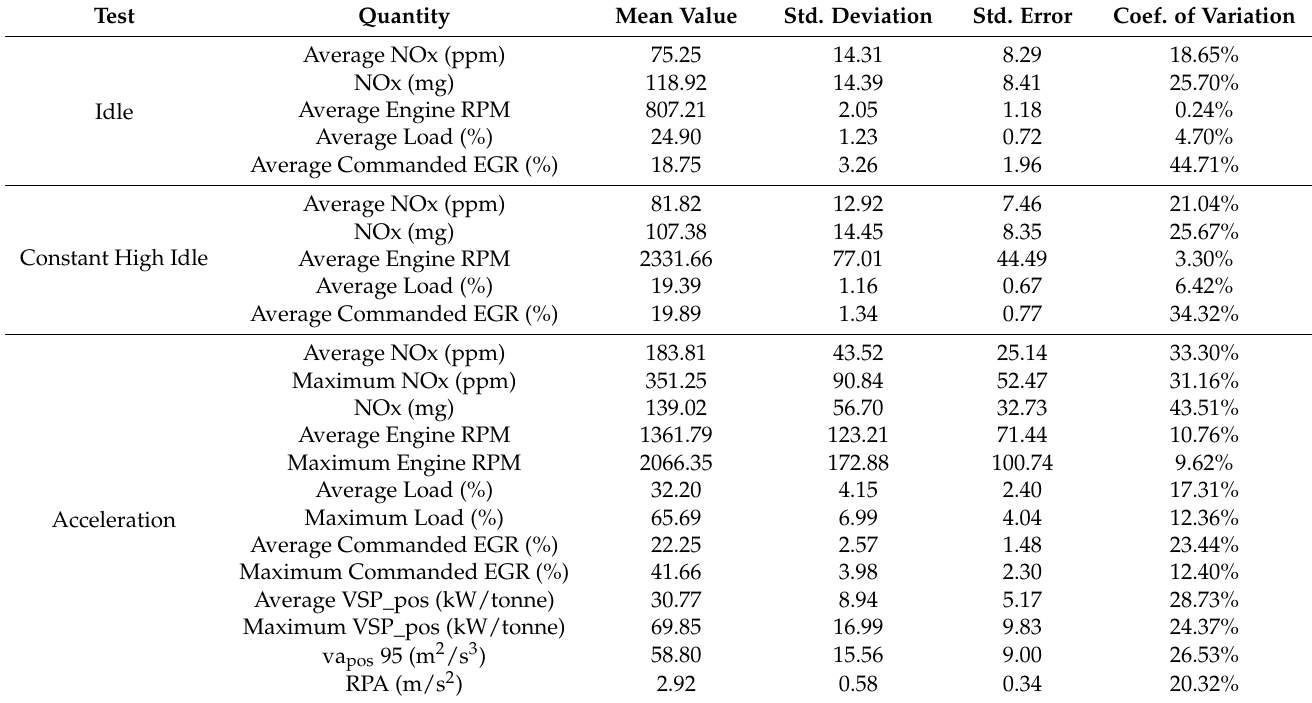
Table 2. Summary of statistical parameters (and mean NOx value, for context) for different character- istics, from the tests that were performed in triplicate for each vehicle (Protocols V01 and